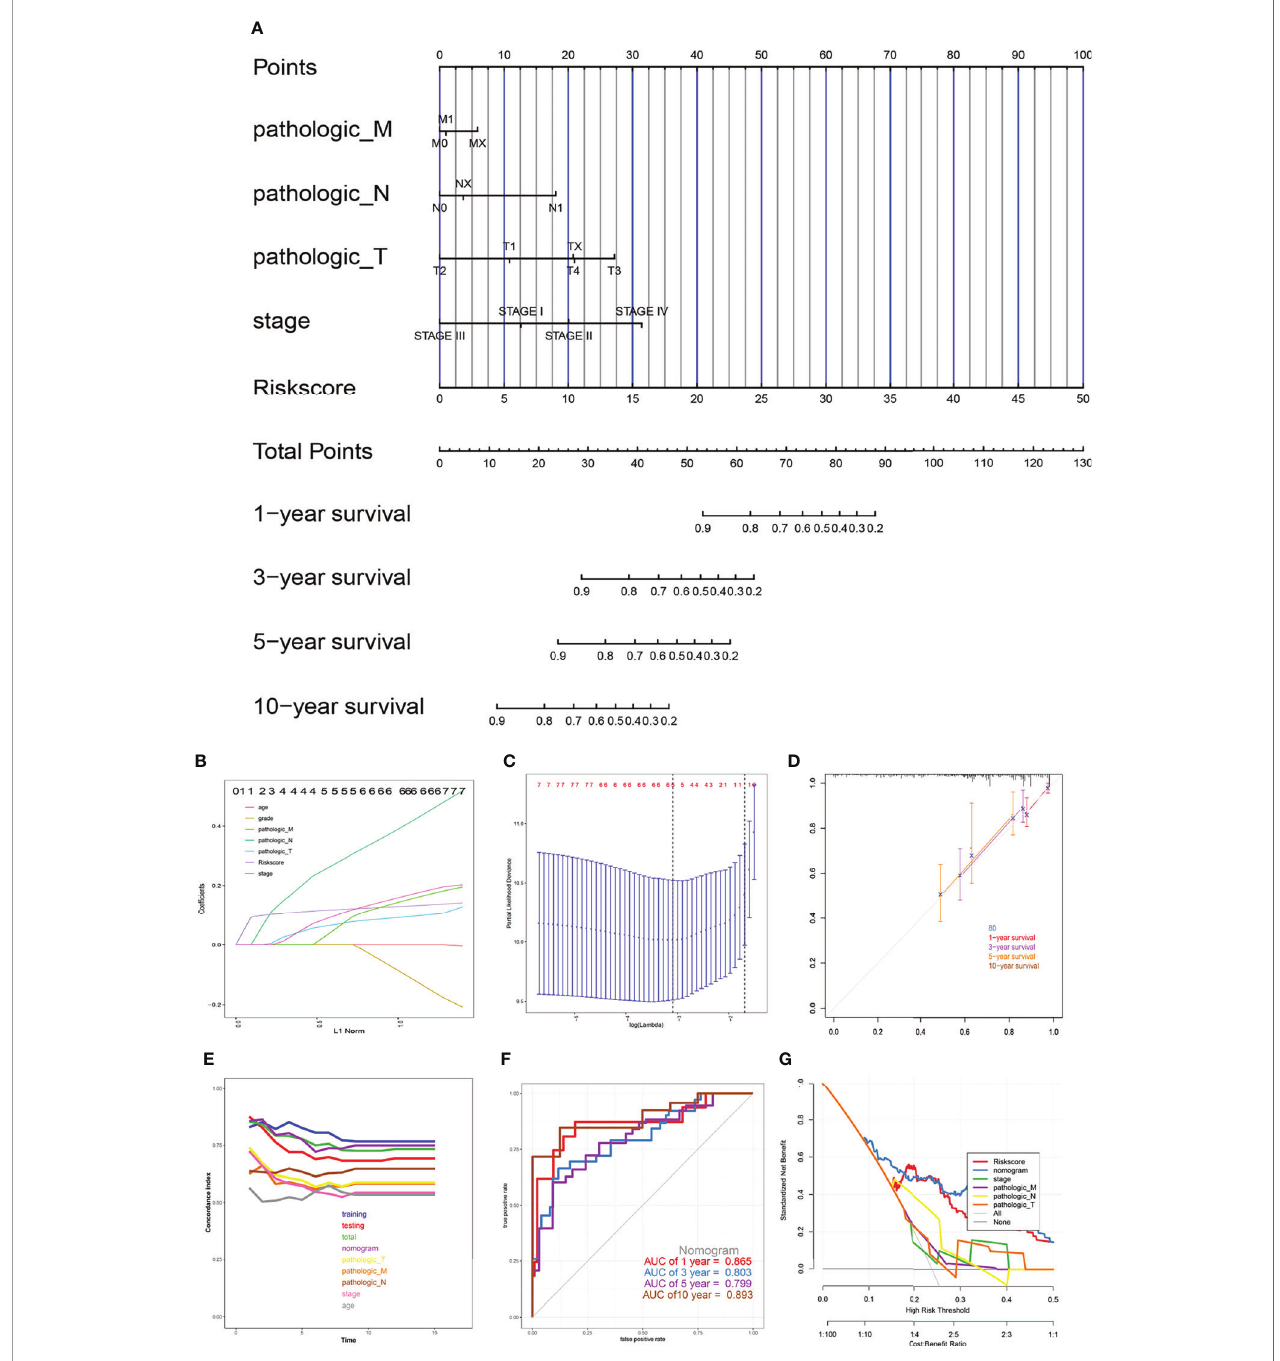
FIGURE 10 | The nomogram model. (A) Prognostic nomogram for patients with cervical cancer, (B, C) Construction of prognostic nomogram models, (D) Calibration curves, (E) The calculation of the C-indexes in nine models, (F) ROC curve of overall survival for eight genes signature and clinical parameters, (G) Decision curve